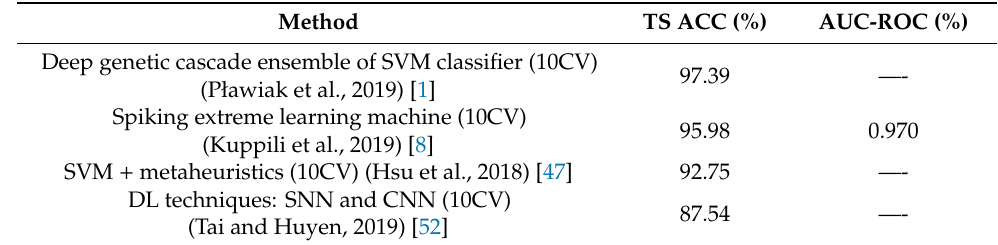
Table 6. Comparison of the performance of high-accuracy classifiers for the Australian credit scoring dataset.